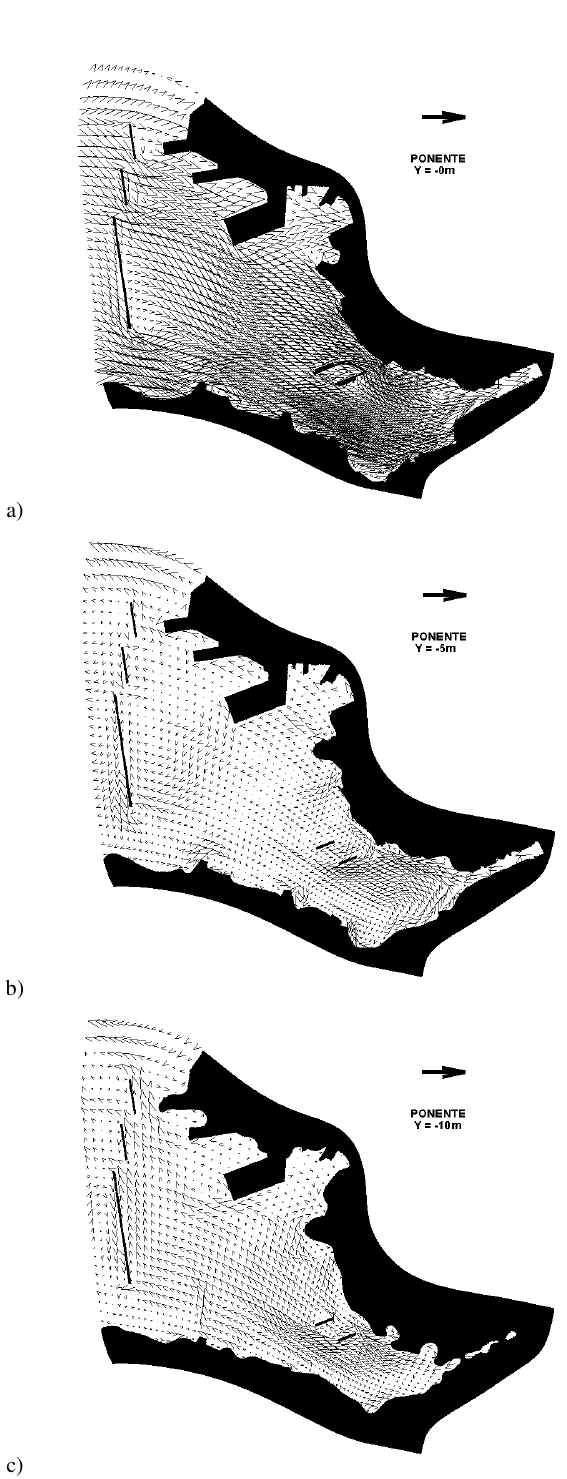
Fig. 16. Horizontal velocity vector field for Ponente wind simula- tion averaged over a period of three hours; for clarity purposes, only one vector is shown every 15 points in x and z . (a) Sea surface; (b) 5m below the sea surface; (c) 10m below the free surface.